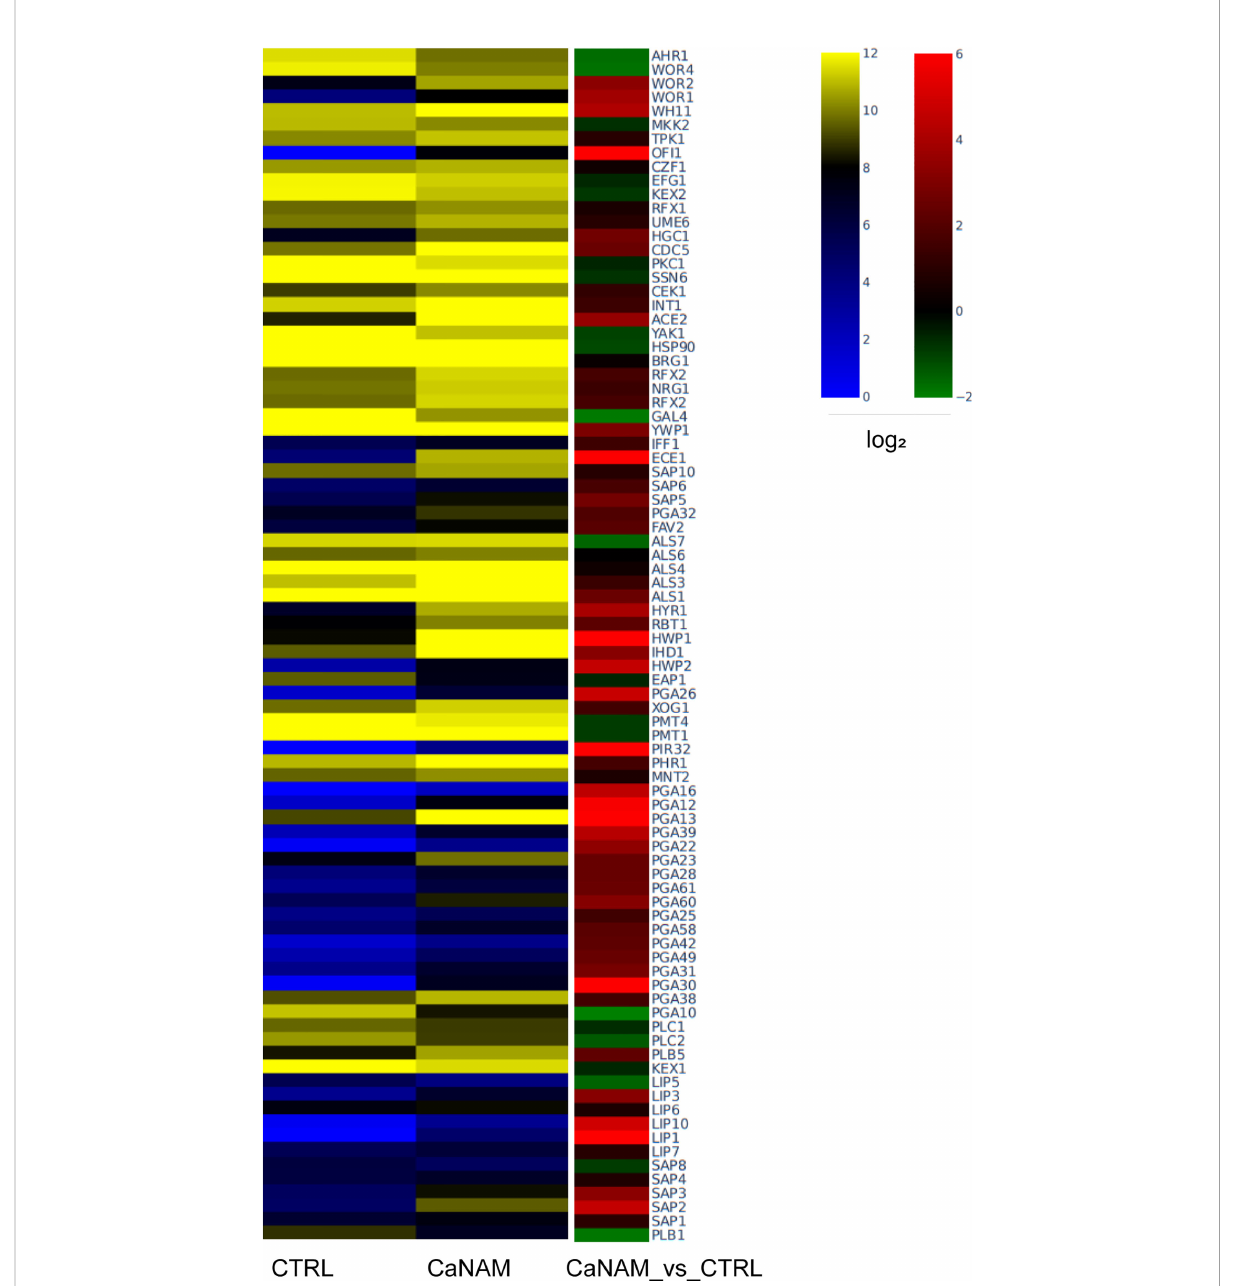
FIGURE 8 Dysregulated genes upon 10 mM NAM treatment. Heatmap showing log 2 expression levels in RPKM (left) and log 2 fold difference value (right) of selected upregulated genes involved in C. albicans virulence (Fold Change, |FC| ≥ 1.5, FDR